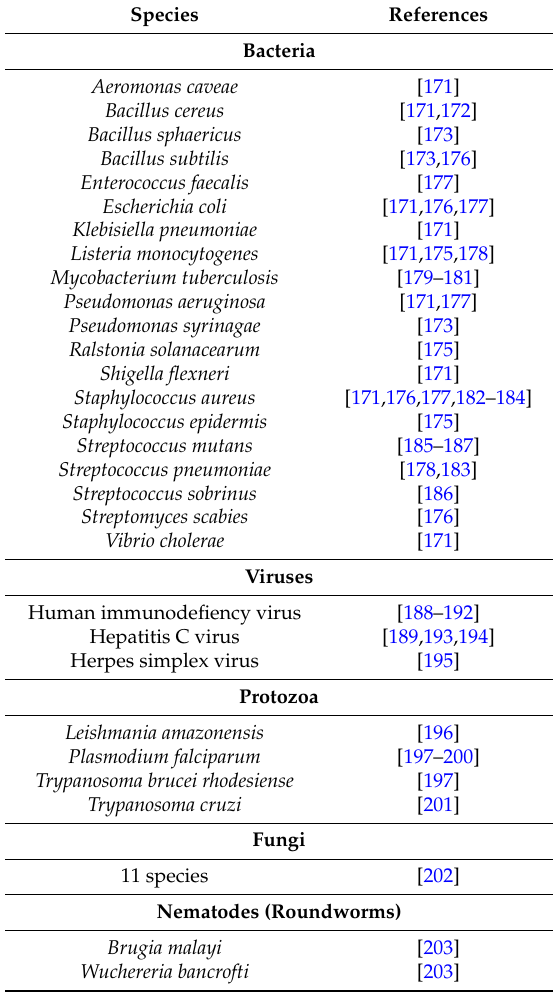
Table 3. Anti-microbial and anti-parasitic activity of ursolic